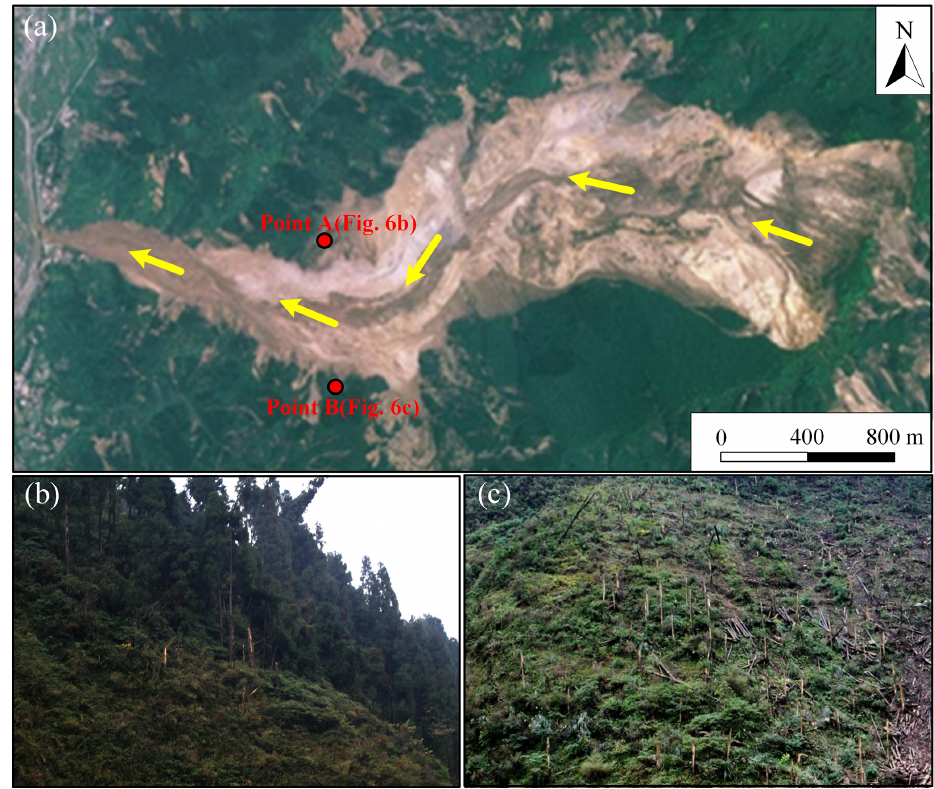
Figure 6. Wenjia Valley avalanche-induced air blast (according to Zhuang et al., 2019). (a) Overview of the Wenjia Valley avalanche. (b–c) Trees damaged by the generated air